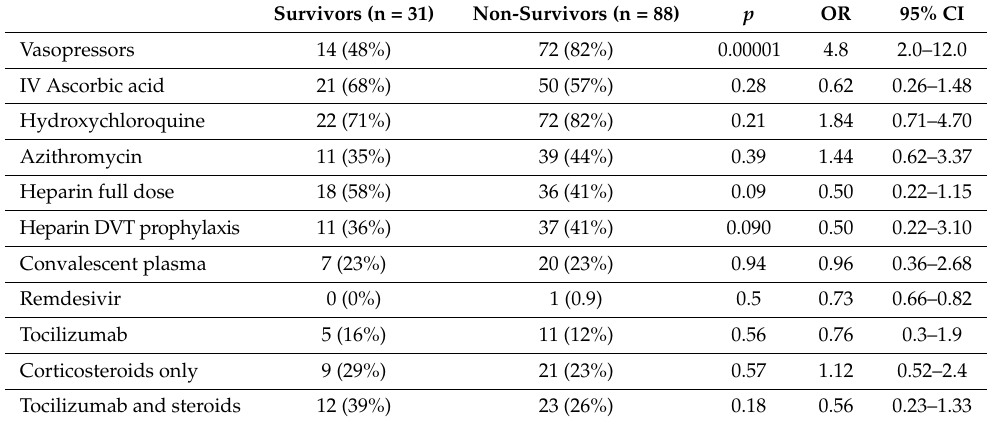
Table 9. Pharmacologic interventions in COVID-19 ICU survivors and non-survivors with AKI.